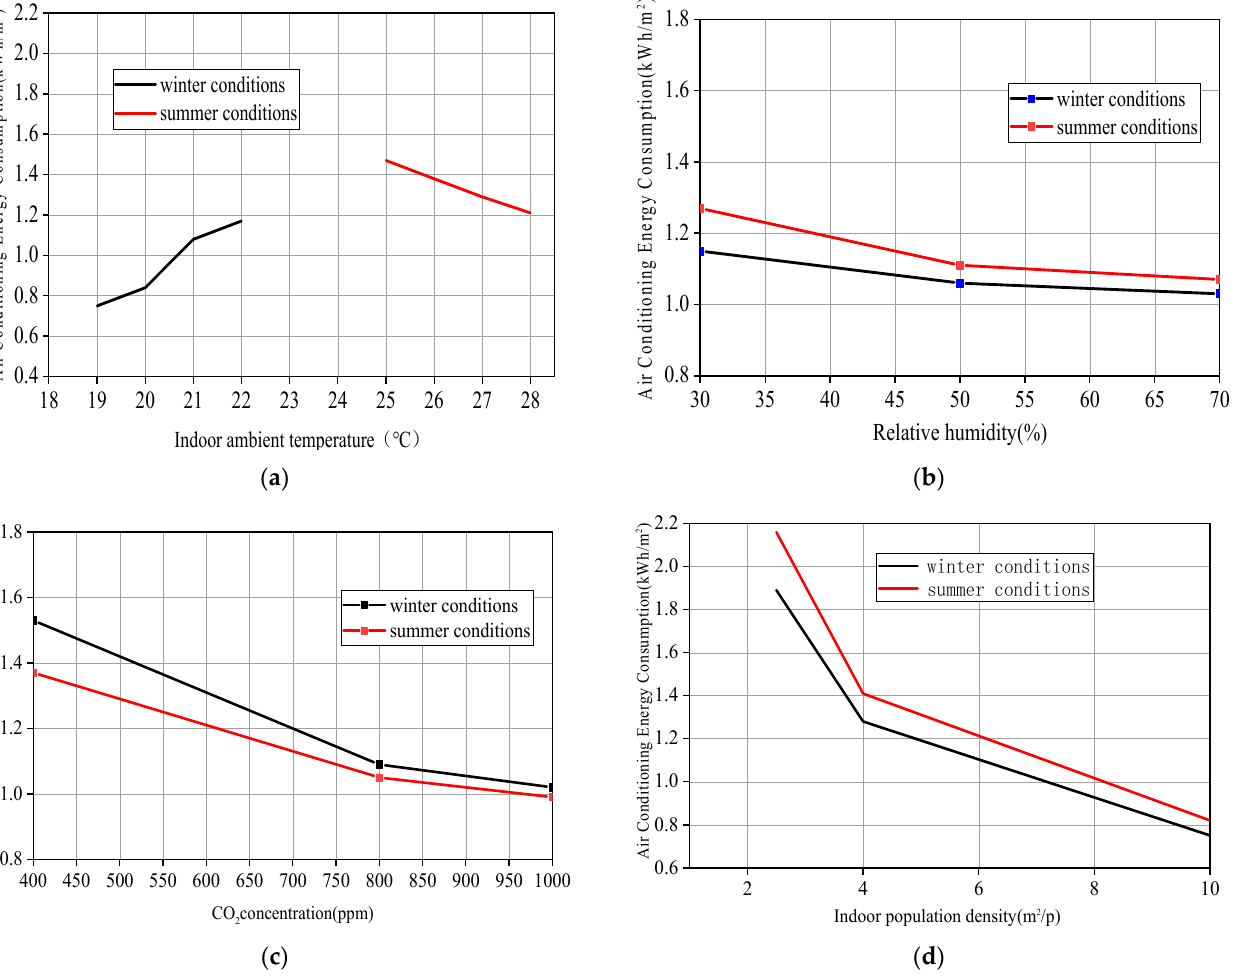
Figure 7. Influence of Indoor Environmental Parameters. ( a ) Correlation between temperature and air conditioning energy consumption. ( b ) Correlation between relative humidity and air conditioning energy consumption. ( c ) Correlation between CO 2 concentration and air conditioning energy consumption. ( d ) Correlation between population density and air conditioning energy consumption.